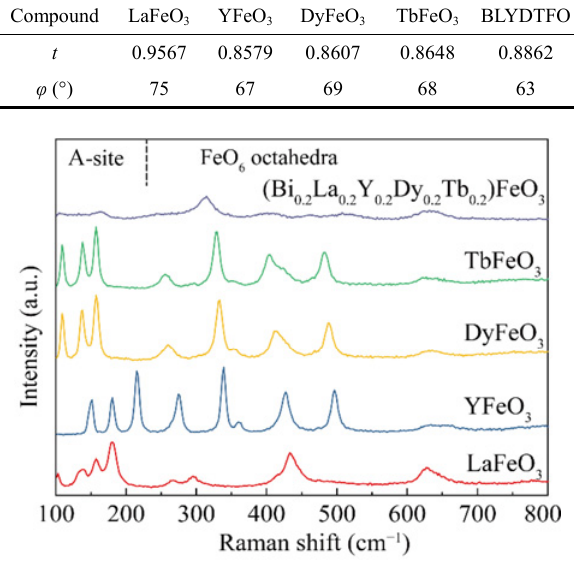
Table 1 t and φ in quadrilateral of four oxygen atoms Compound